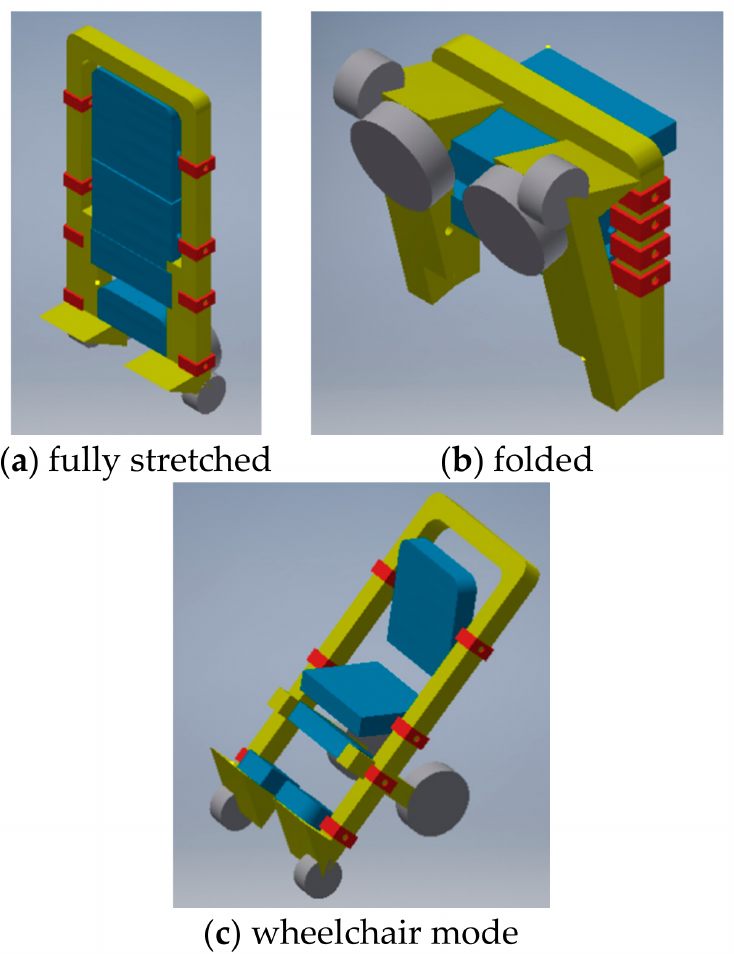
Figure 1. 3D models of the stretcher in its fully stretched, folded and wheelchair-transformed state